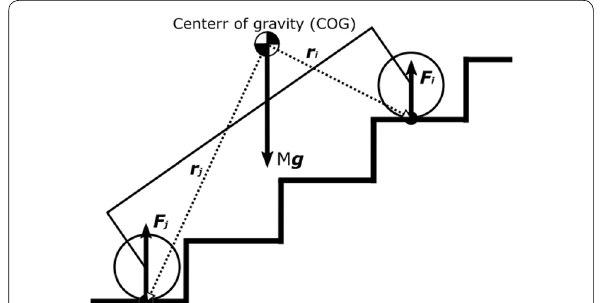
Fig. 3 Vehicle on a set of